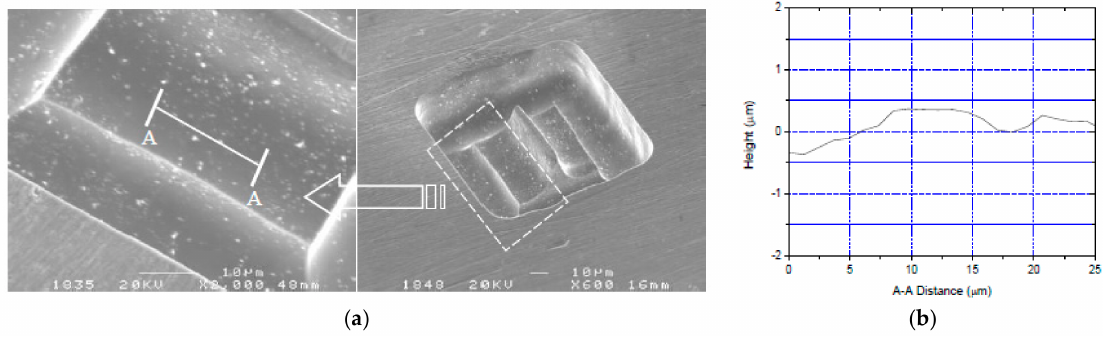
Figure 16. A 3D complex micro-structure. ( a ) A square cavity structure; ( b ) The cross section surface